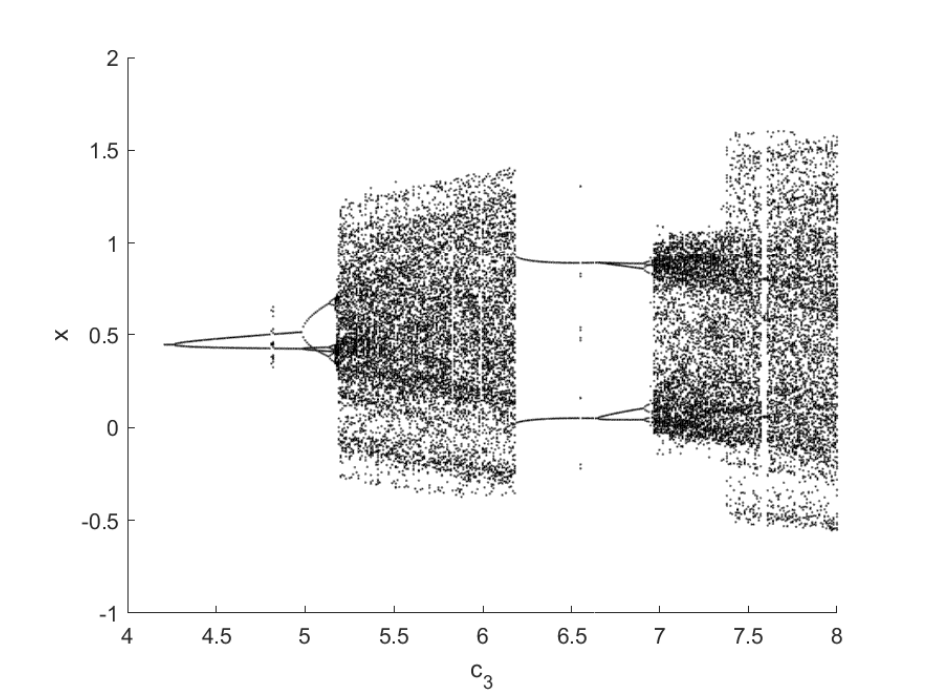
Figure 2. Bifurcation diagram of the Ikeda